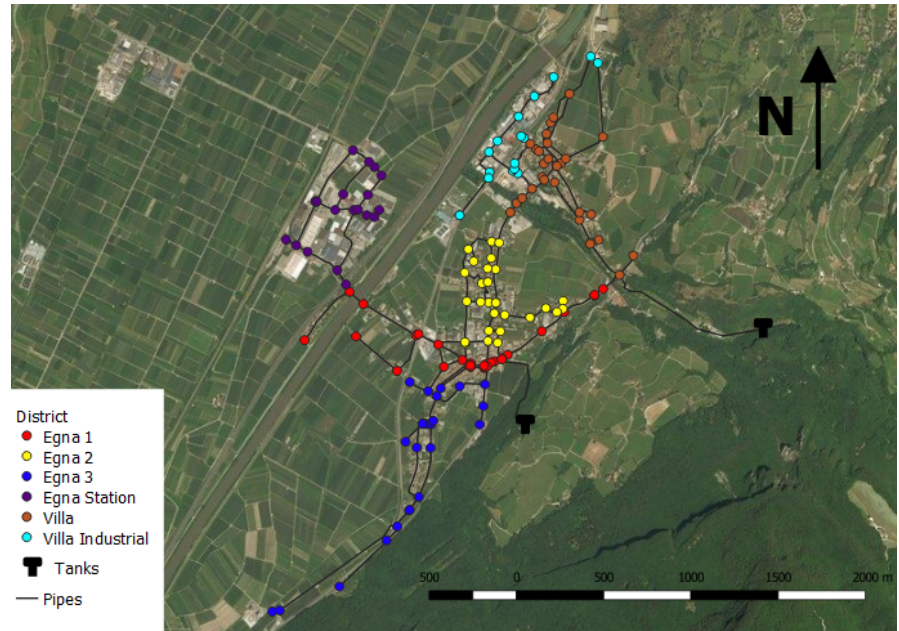
Figure 7. The water distribution system of Egna and its six